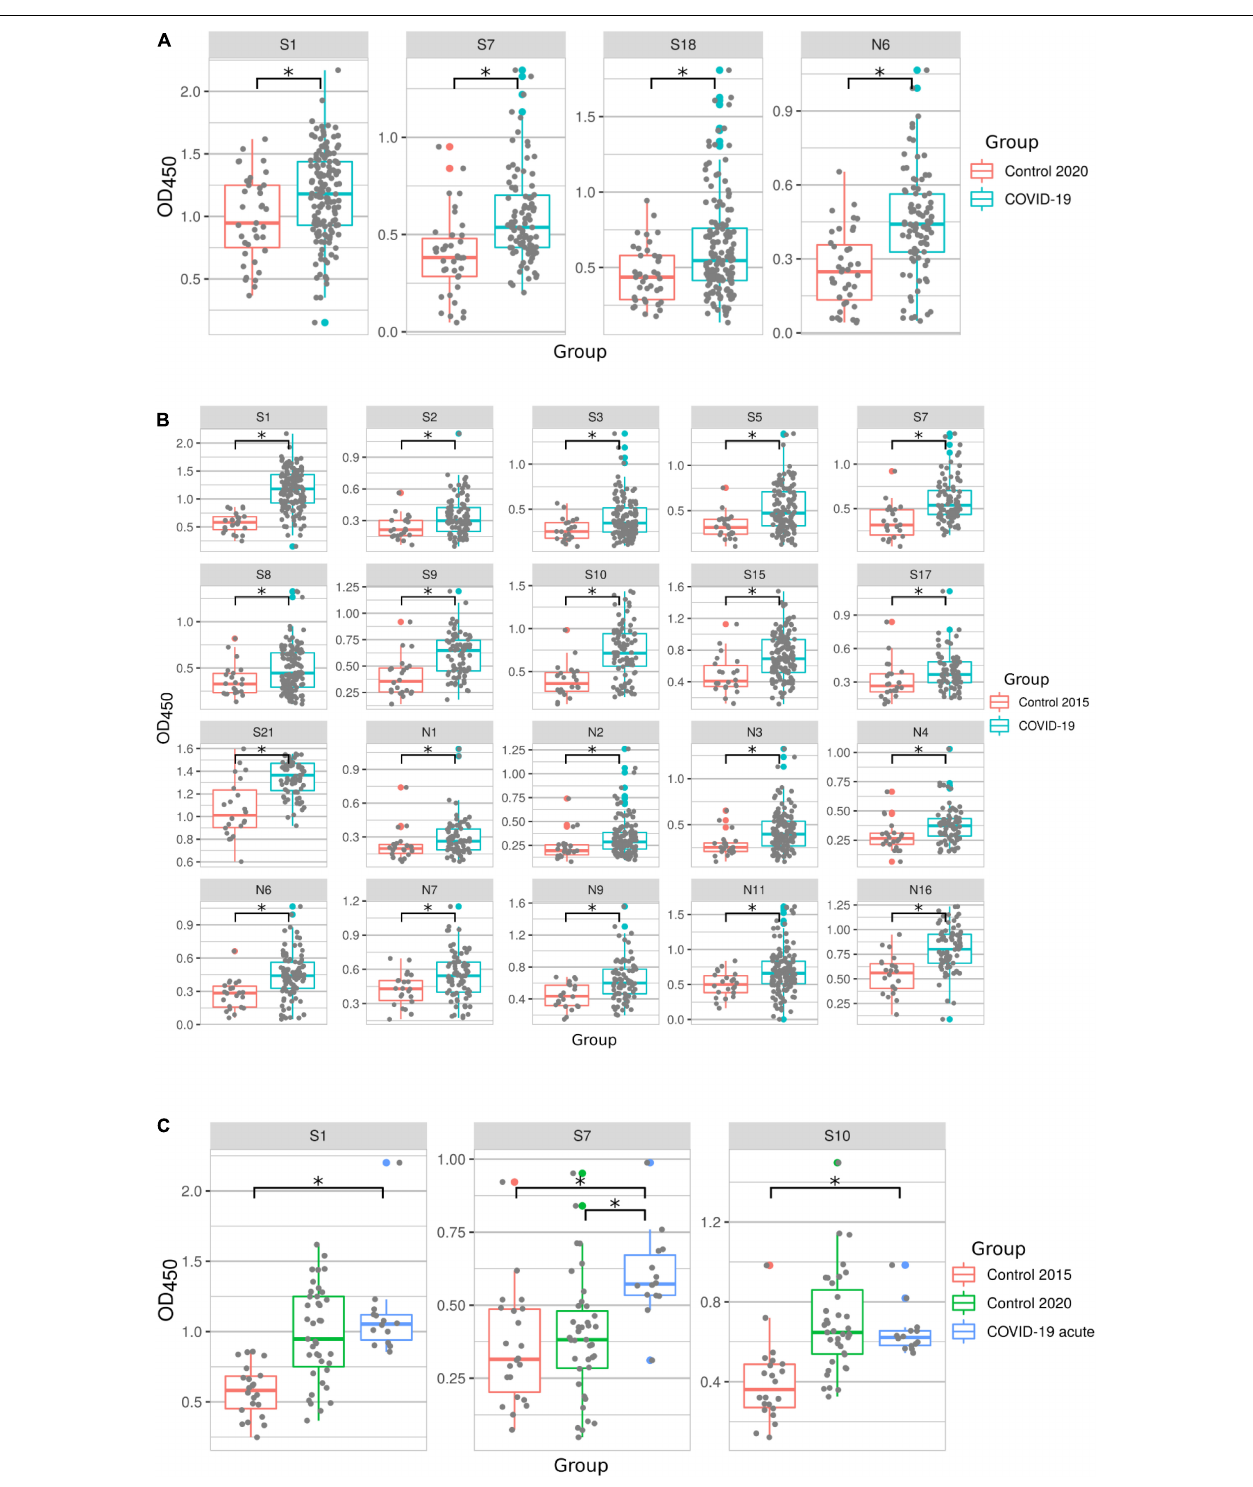
FIGURE 2 | COVID-19 serum reactivity with SARS-CoV-2 peptides. Antibody reactivity was analyzed using ELISA. Peptides were adsorbed on a 384-well plate and probed with serum samples. Data is displayed for: (A) – peptides with increased reactivity in convalescent COVID-19 samples compared to controls collected in 2020; (B) – peptides with increased reactivity in convalescent COVID-19 samples compared to controls collected in 2015; (C) – peptides with increased reactivity in acute COVID-19 samples compared to controls collected in 2015 and 2020. Asterisks indicate statistically significant differences between reactivity to SARS-CoV-2 peptides ( p < 0.05, Kruskal-Wallis